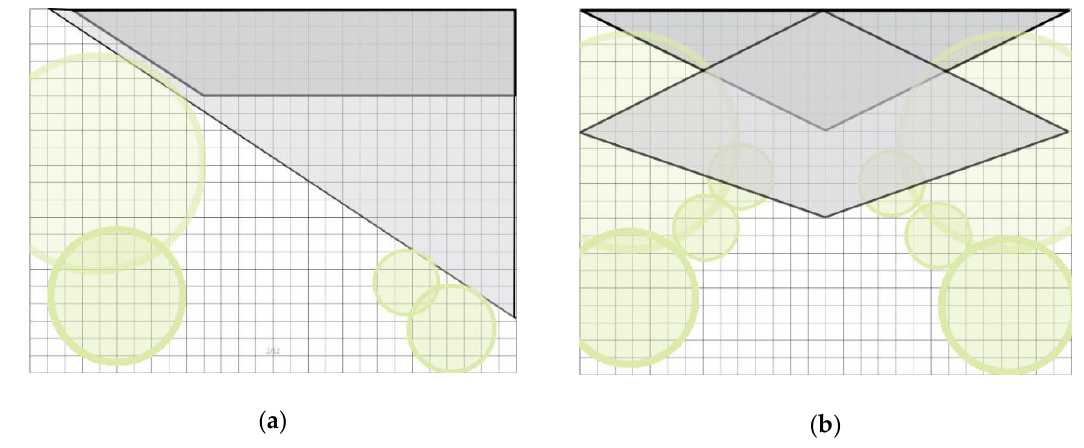
Figure 9. Di ff erent space types: ( a ) environmental mode one side; ( b ) environmental mode Figure 9. Different space types: ( a ) environmental mode one side; ( b ) environmental mode bilateral.